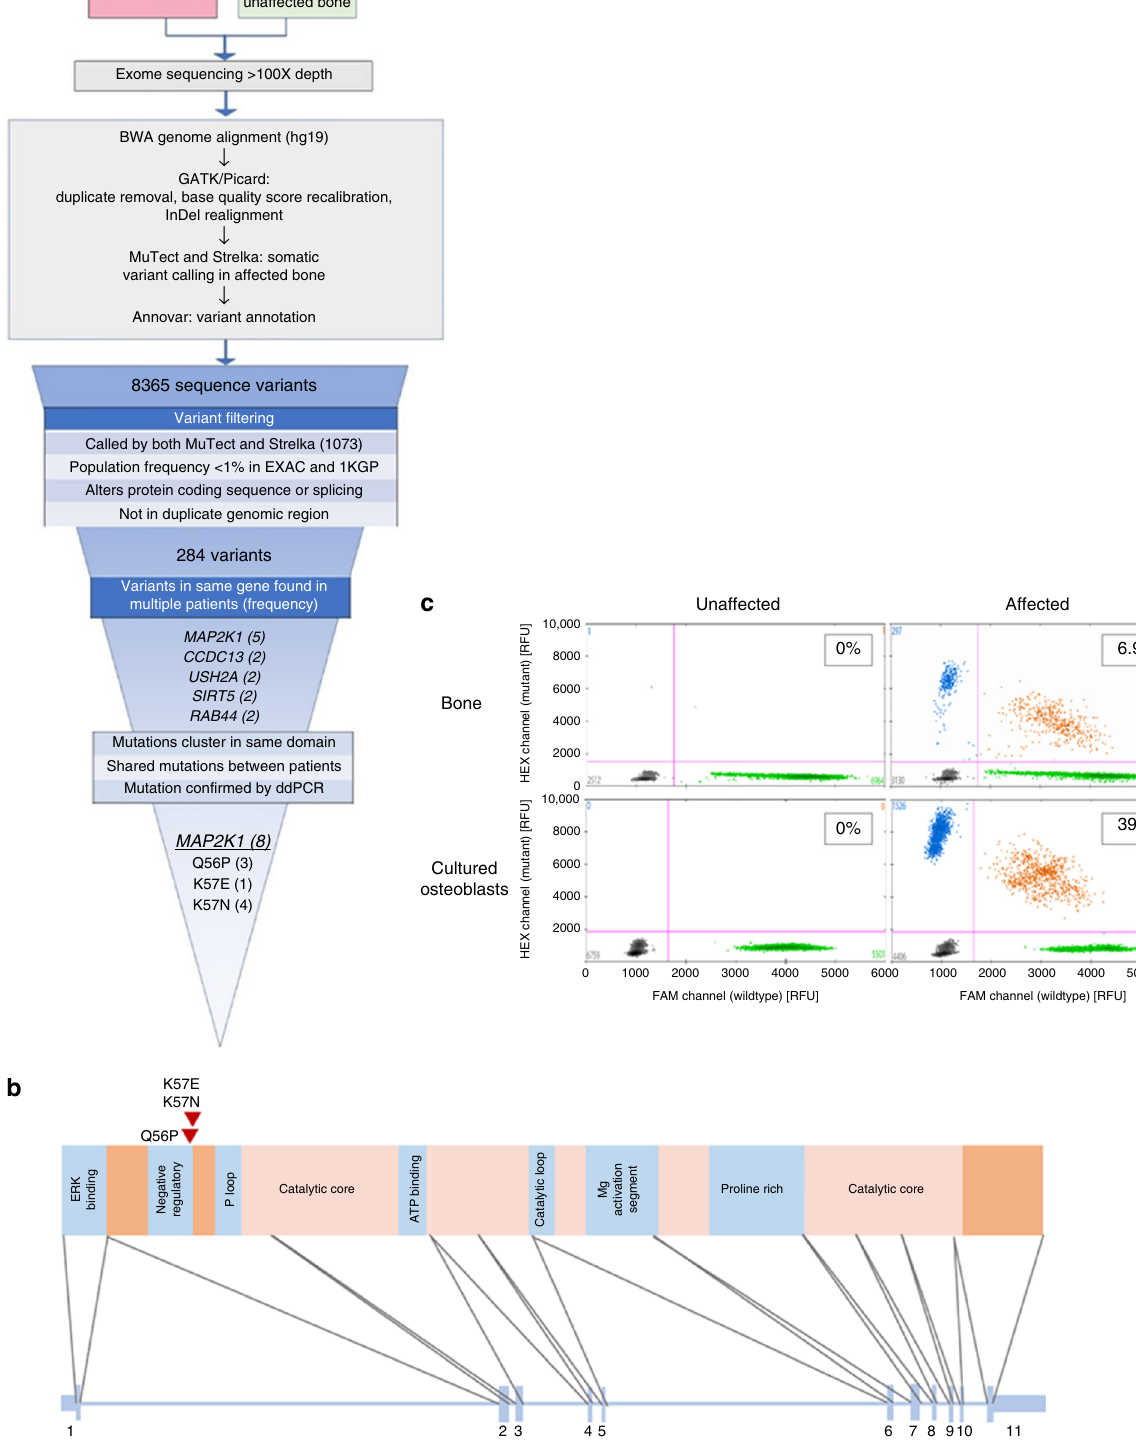
Fig. 2 MAP2K1 somatic mutations in melorheostotic bone. a Flowchart of genetic analysis. b Schematic of the MAP2K1 exon structure encoding MEK1 protein domains. The three mutations from the eight patients are clustered in the negative regulatory domain. c Quanti fi cation of mutant allele abundance by ddPCR in unaffected and affected bone biopsies (top row), as well as in cultured osteoblasts from the respective biopsies (bottom row), from patient Melo-2 identi fi ed by WES to have a p.K57N mutation in affected bone. Each dot represents a droplet, with blue being mutant positive, green being wildtype positive, and orange being positive for both. Color-matched numbers correspond to count of droplets per quadrant. The boxed number is the fractional abundance of mutant allele in each